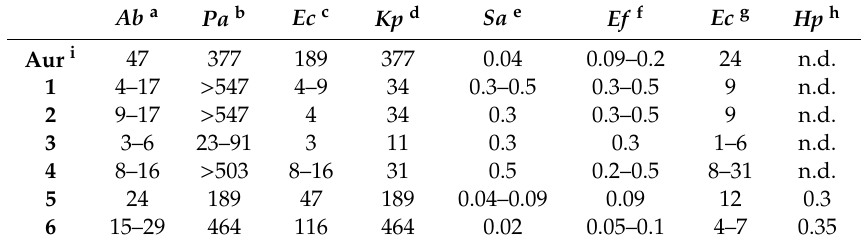
Table 1. Minimum inhibitory concentration (MIC) values for auranofin analogues against a series of Gram( + ) and Gram( − ) strains (in µ M).